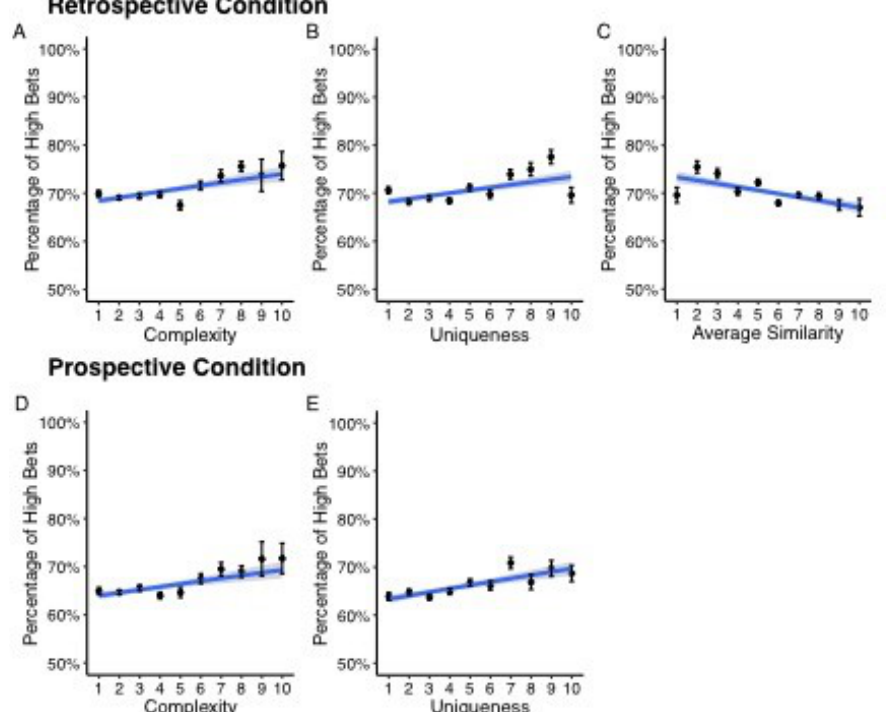
Figure 3. Effect of additional visual features on confidence. A-C. In the retrospective condition, complexity and uniqueness were positively correlated with the proportion of high-risk bets, such that as the images were more complex, or more unique (compared to all other images in the image back) subjects were more likely to make high bets. Average similarity between the sample and distractors was negatively correlated such that as the sample and distractor images became more similar, subjects were less likely to make high bets. D, E. In the prospective condition complexity and uniqueness were positively correlated with the proportion of high-risk bets. For each regression only correct trials are included to control for any effects of accuracy. The blue lines are fits from logistic regressions and the gray regions are the 95% confidence intervals. The data was binned into 10 groups per variable for visualization purposes. The error bars represent the SE of the